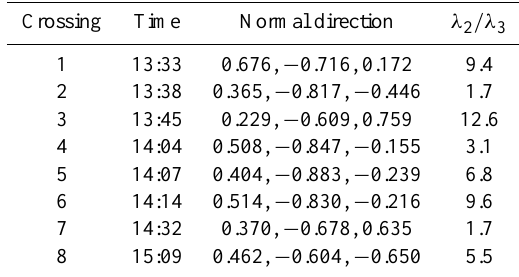
Table 2. Neutral sheet crossings on 5 August 2004 by